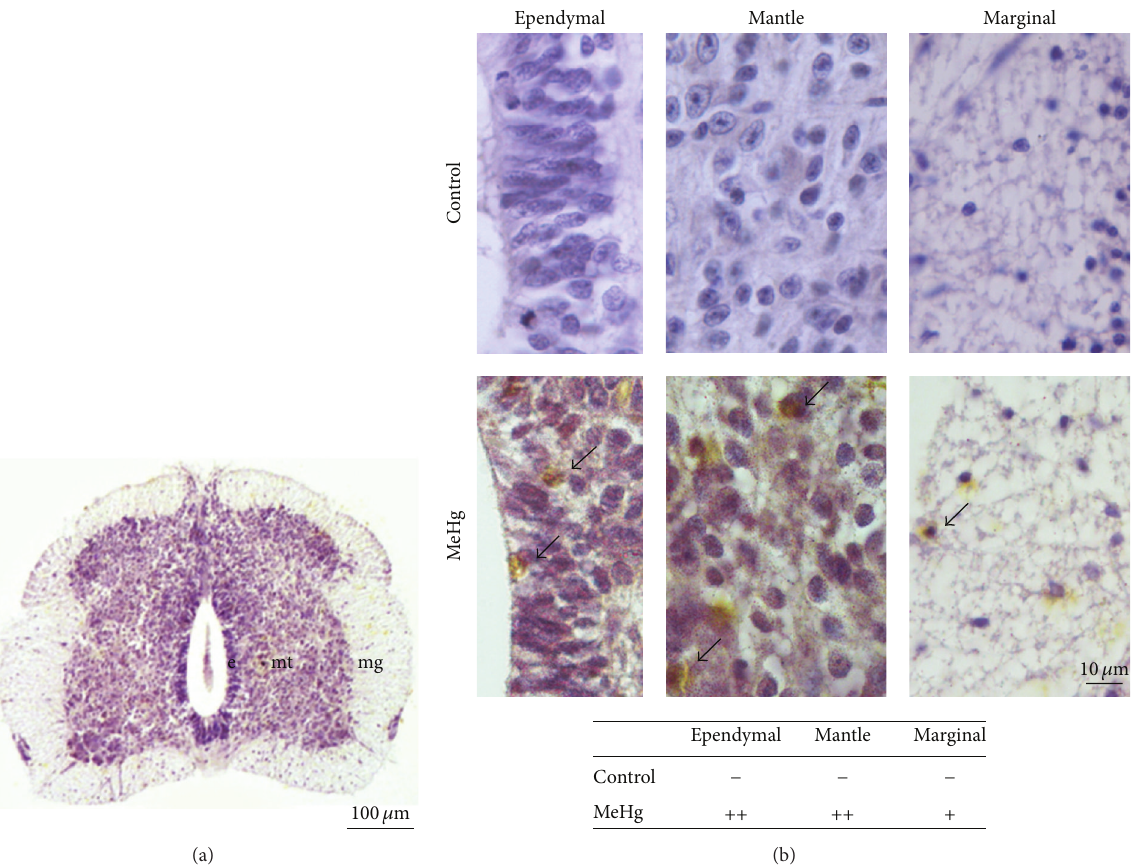
Figure 1: Mercury deposition in the spinal cord of E10 control and MeHg-treated embryos examined by the AMG method. Spinal cord showing ependymal (e), mantle (mt), and marginal (mg) layers in low magnification (a) and high magnification (b). The brown color corresponds to the mercury deposits in cells (arrows) in MeHg-treated embryos. The accompanying table displays the intensity of mercury deposition in the cells of the spinal cord layers, classified as absent ( − ), mild (+), and moderate (++).